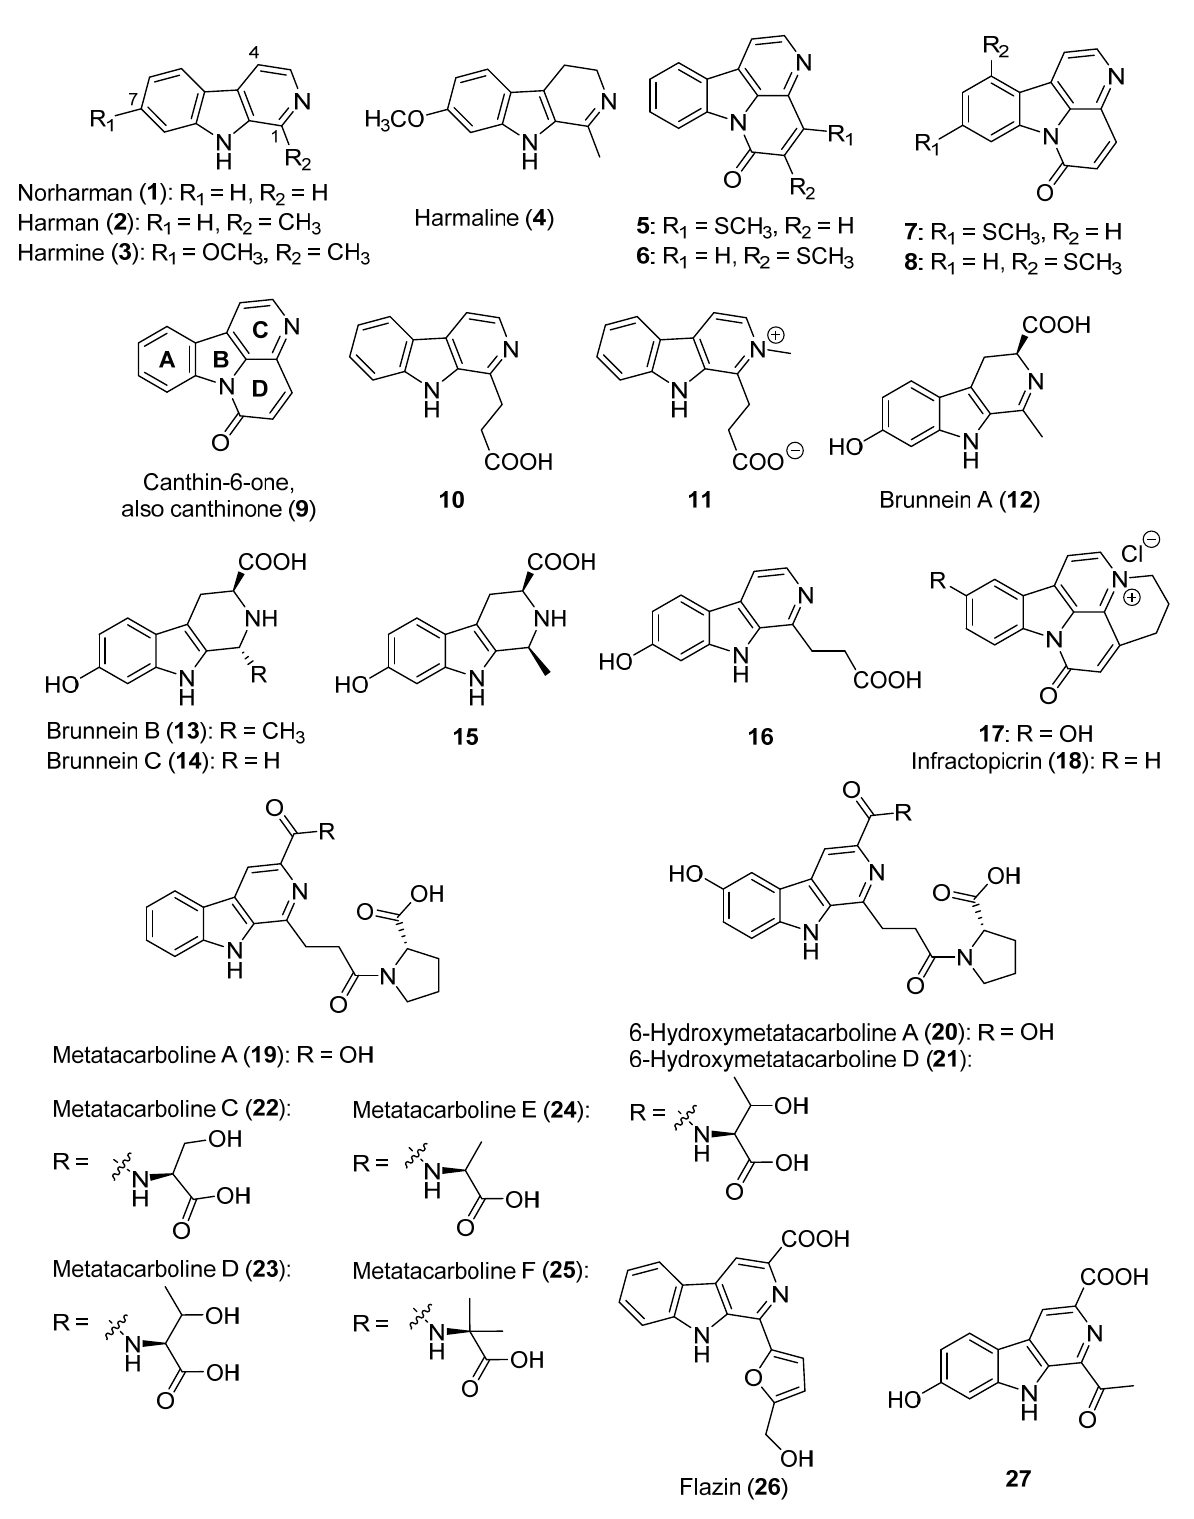
Figure 2. The structures of the β -carboline alkaloids isolated from mushrooms ( 1 – 27 ). Three new compounds, named brunneins A–C ( 12 – 14 , Figure 2), were isolated from Cortinarius brunneus [26]. Later, brunnein A ( 12 ) was also found in diverse Hygrophorus species [27]. The diastereomer of brunnein B ( 15, Figure 2 ) was also isolated from Cyclocybe cylindracea , and exhibited a marked antioxidant activity [28]. In addition, acid 16 (Figure 2) was isolated from C. brunneus , which was the first time from a non-vegetal source